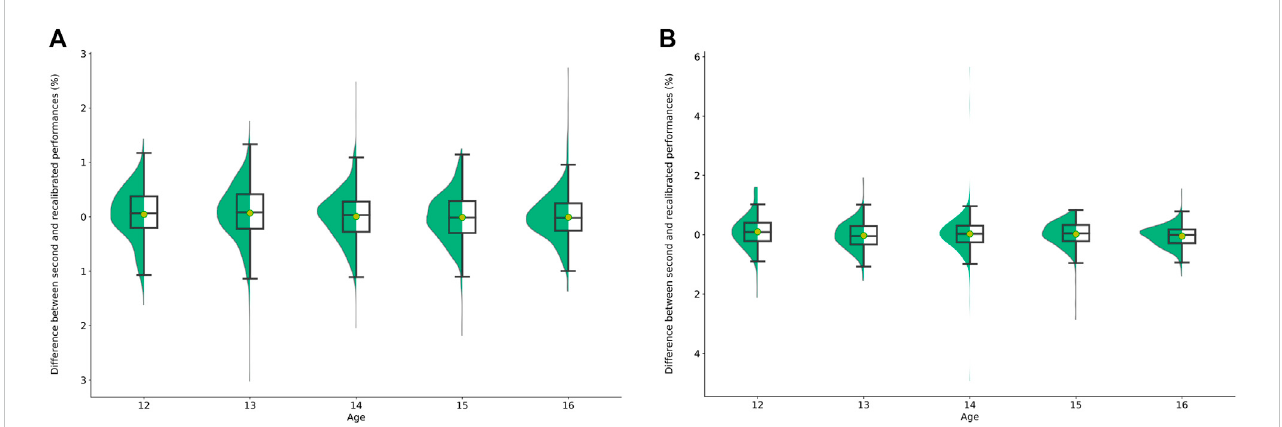
FIGURE 3 (A) Boxplot of percentage differences between rebalanced performances and second performances achieved in the female 100 m of U13 – U17 categories. (B) Boxplot of percentage differences between rebalanced performances and second performances achieved in the male 100 m of U13 – U17